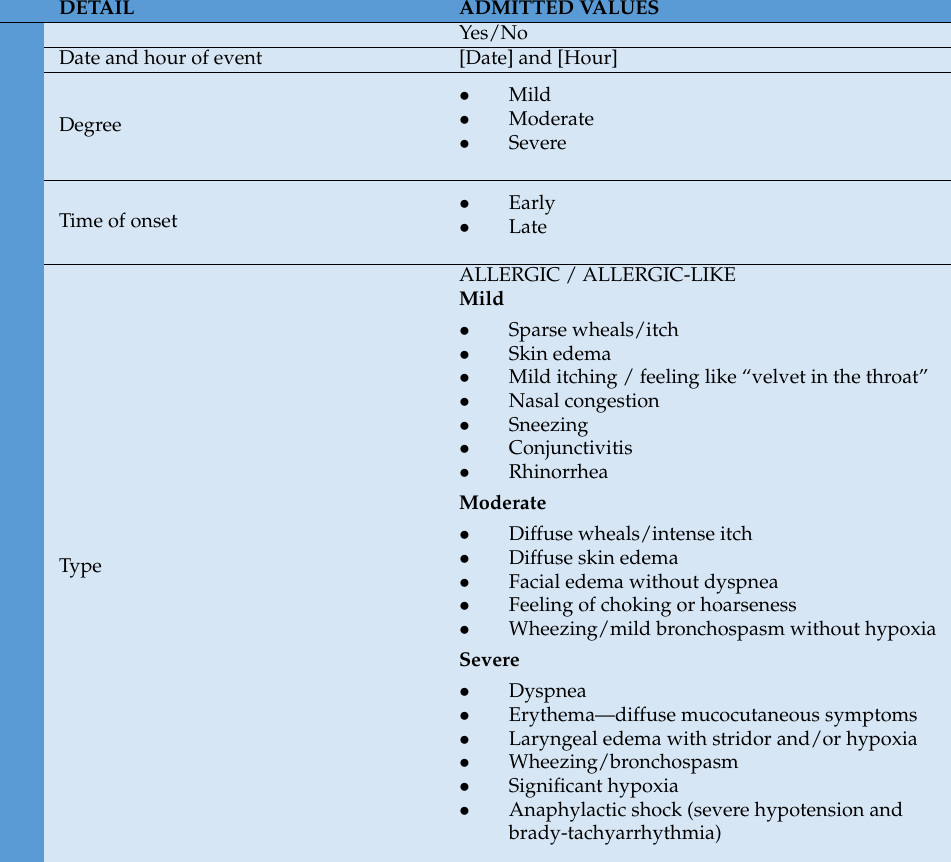
Table A5. ADVERSE